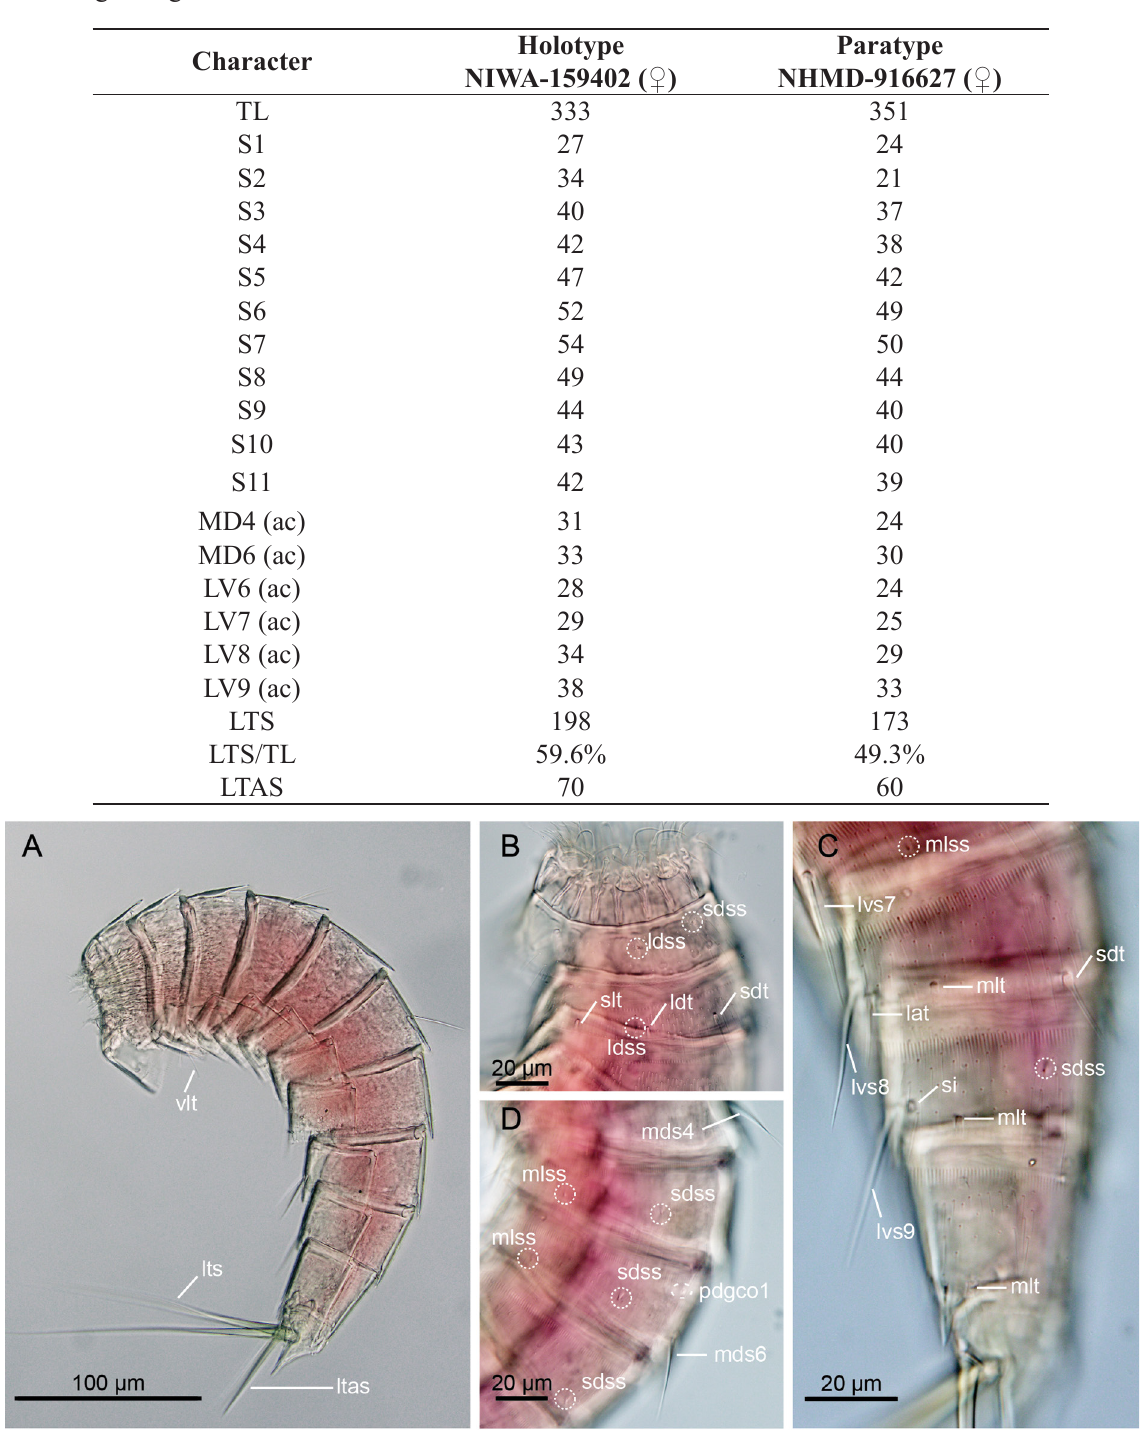
Table 4. Measurements from light microscopy of Echinoderes landersi sp. nov . (in µm) from the Hikurangi